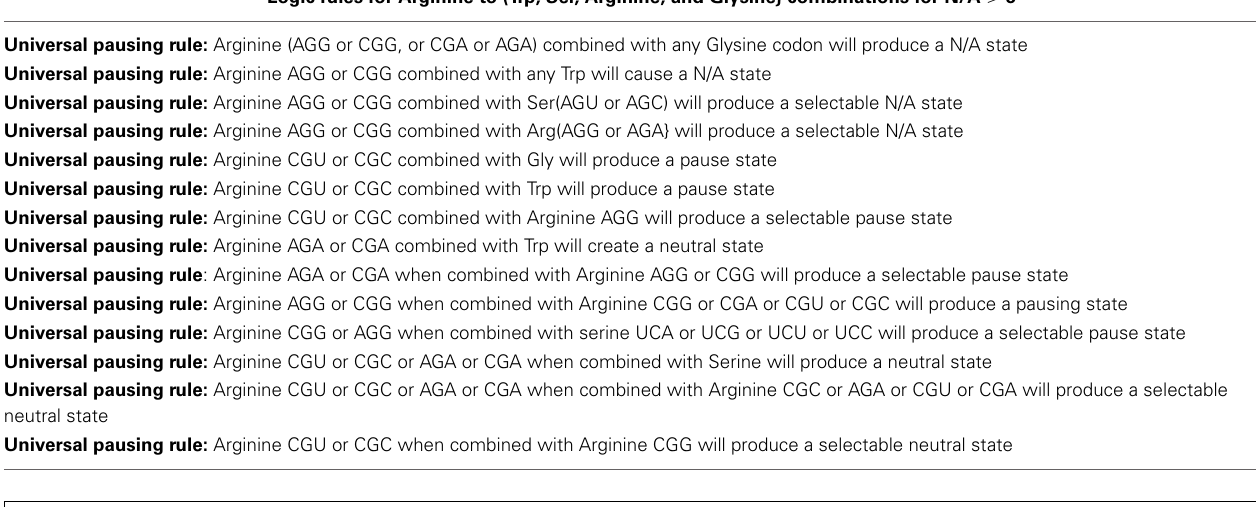
Table 3B | Proposed rules that govern arginine to [trp, ser, arg, gly] combination with respect to pausing, neutral, and N/A states for the N/A metric > 5.